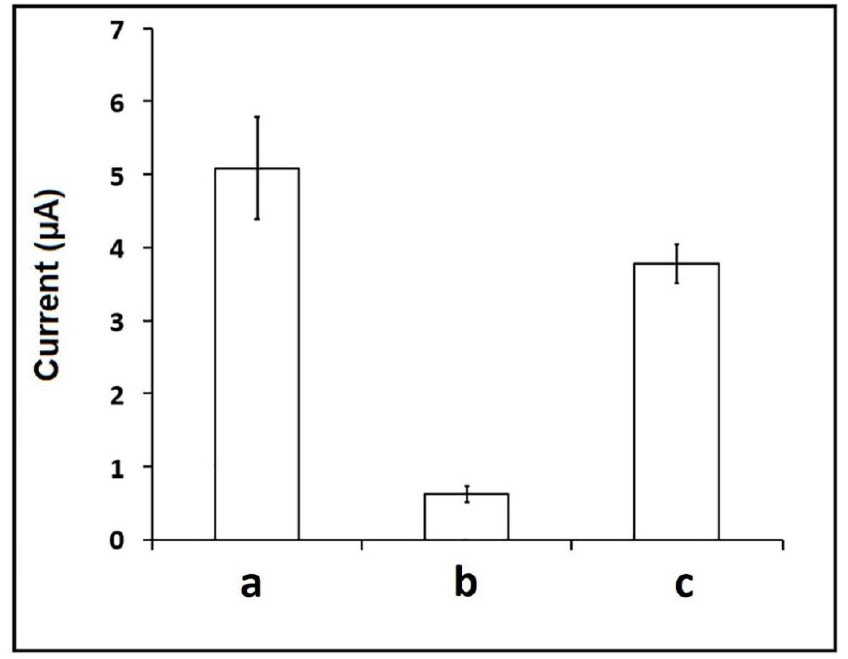
Figure 10. The average guanine signal ( n = 3) after hybridization between BRCA1 probe and BRCA1 target ( a ), or MM ( b ), or mixture of BRCA 1 target and MM ( c ).